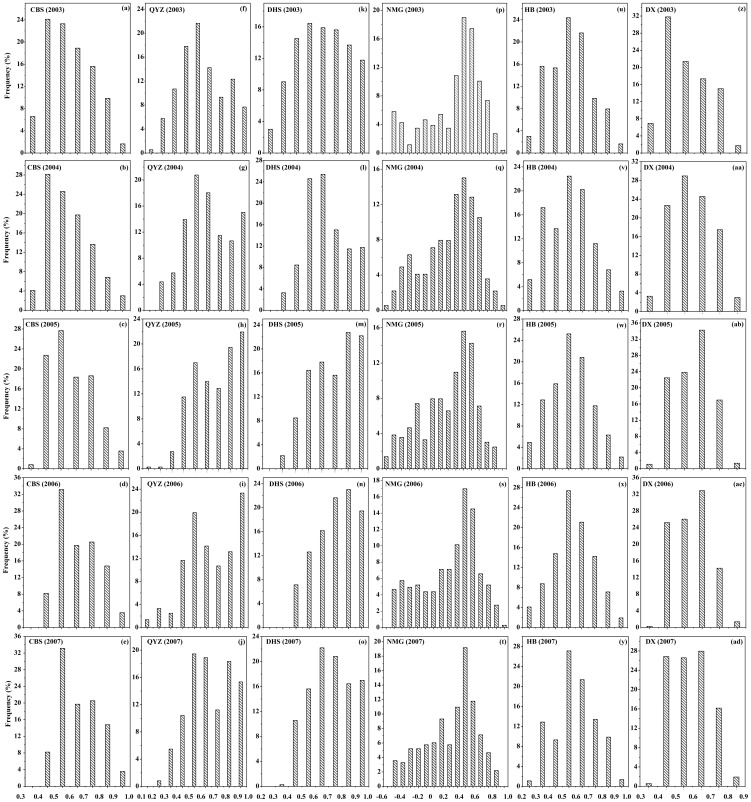
Histograms of the cloudiness index (CI) value at the six sites during the mid-growing seasons from 2003 to 2007.